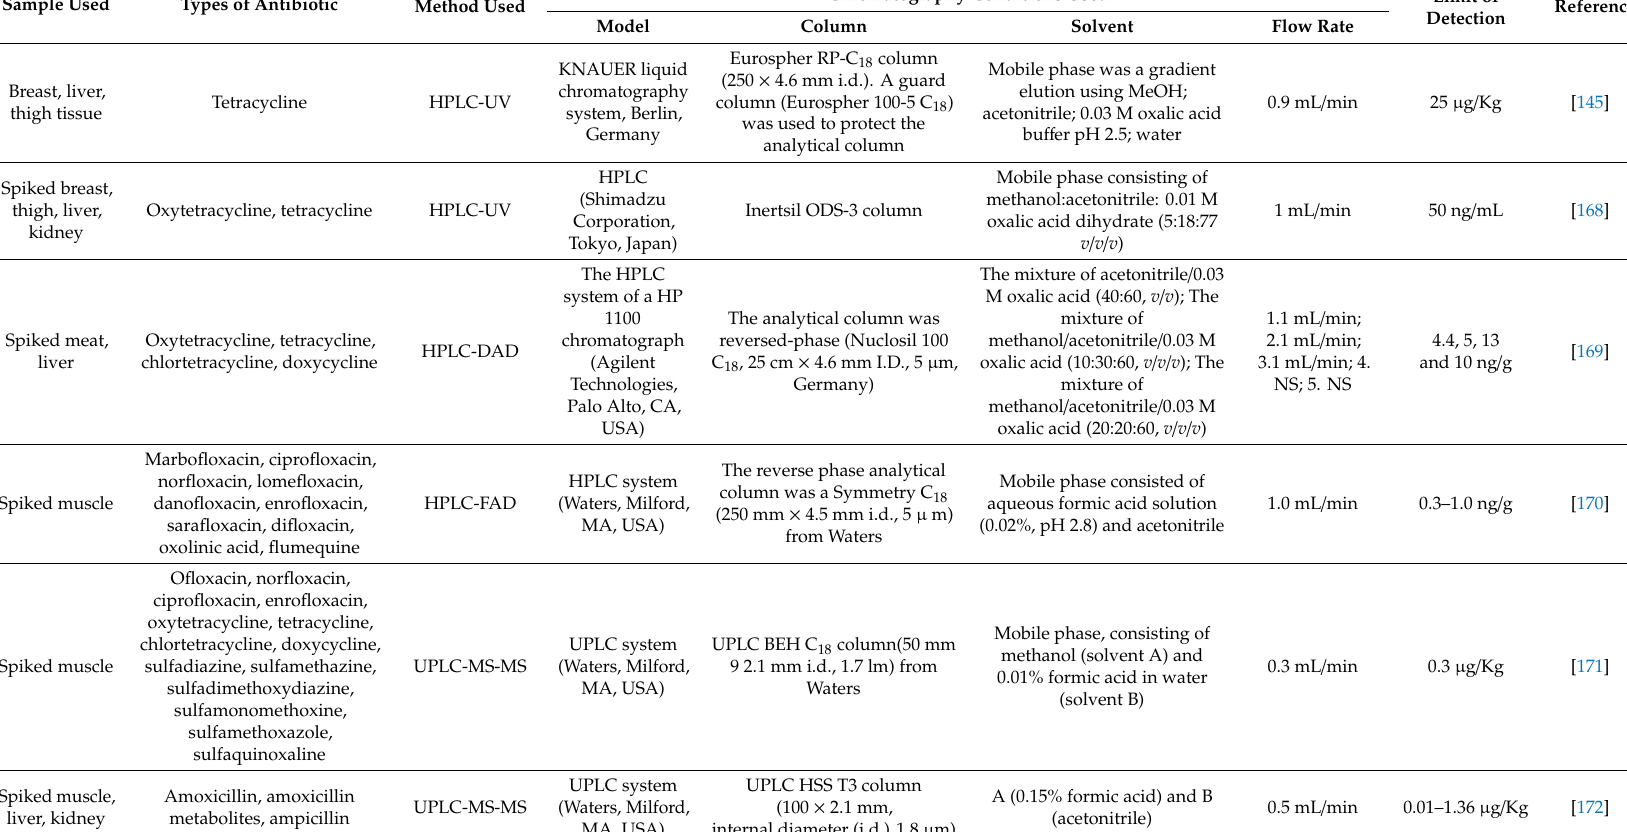
Table 12. HPLC-based approaches used for the detection of antibiotics residue in chicken